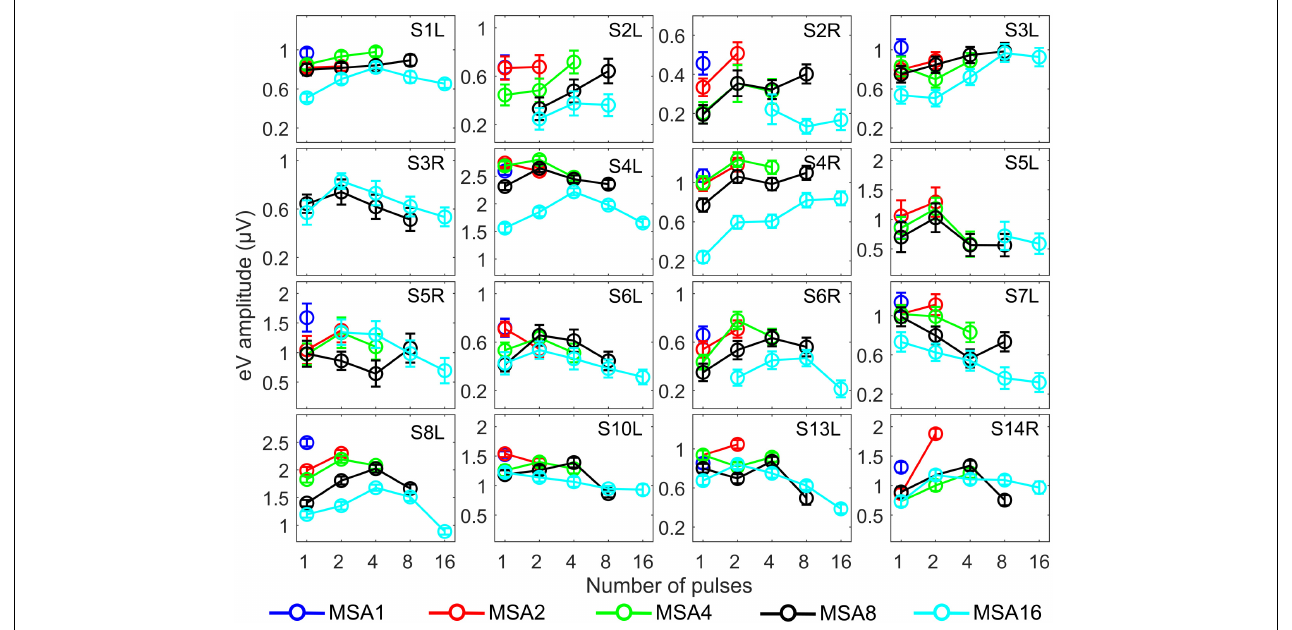
FIGURE 7 | eABR wave eV amplitudes corresponding to the 15 measurement conditions mentioned in Figure 2 . Curves with specific colors represent responses to stimuli with fixed stimulation amplitude and varying numbers of pulses. Error bars indicate ±